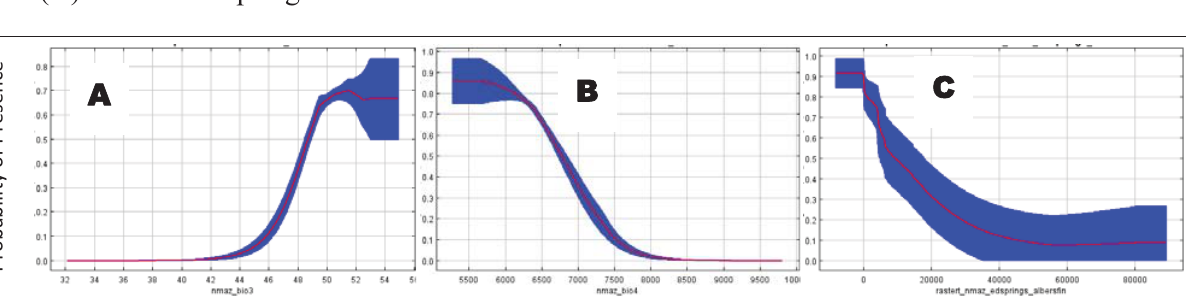
Figure 3. Response curve of the Maxent logistic probability of presence of the white-nosed coati ( Nasua narica ) in Arizona and New Mexico based on the best a priori subset of occurrence records with ( A ) isothermality (Bio 3), ( B ) temperature seasonality (Bio 4), and ( C ) distance to